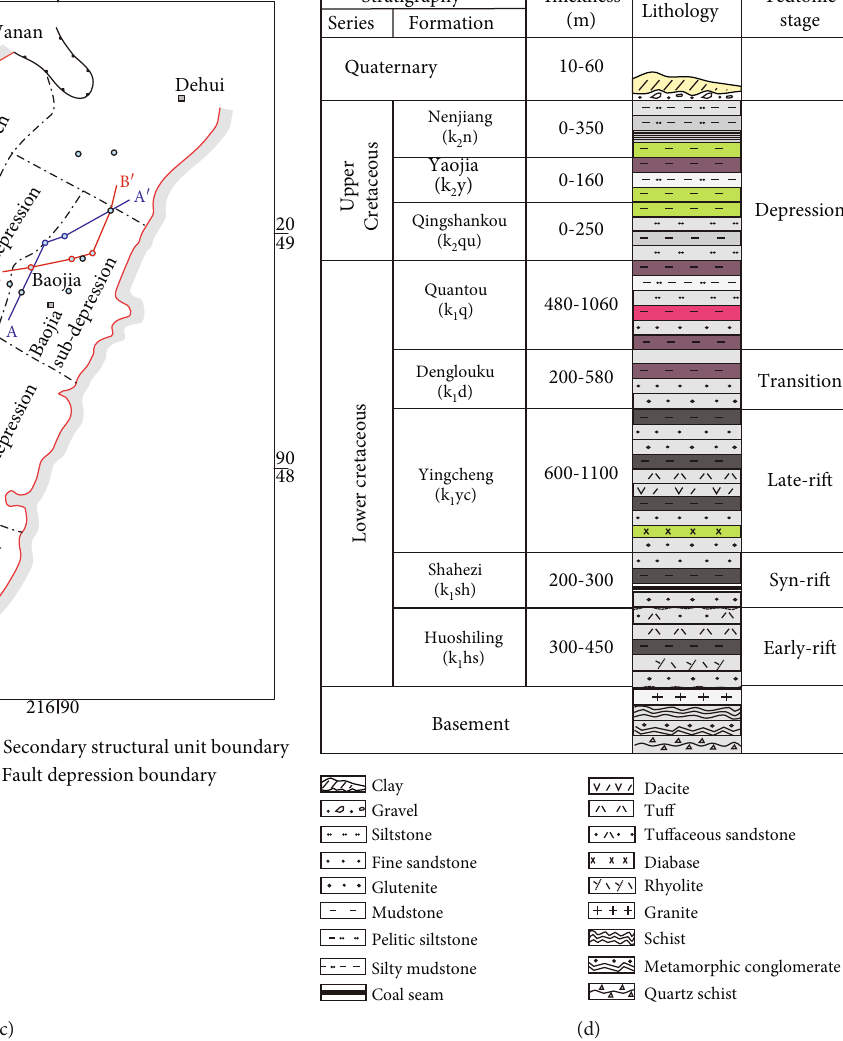
Figure 1: (a) Geographic location of the Songliao Basin. (b) Location of Dehui Depression in the Southern Songliao Basin. (c) Tectonic units of the Dehui Depression. (d) Generalized Mesozoic-Cenozoic stratigraphy of the Dehui depression, showing the formation thickness, lithology, and stage of tectonic